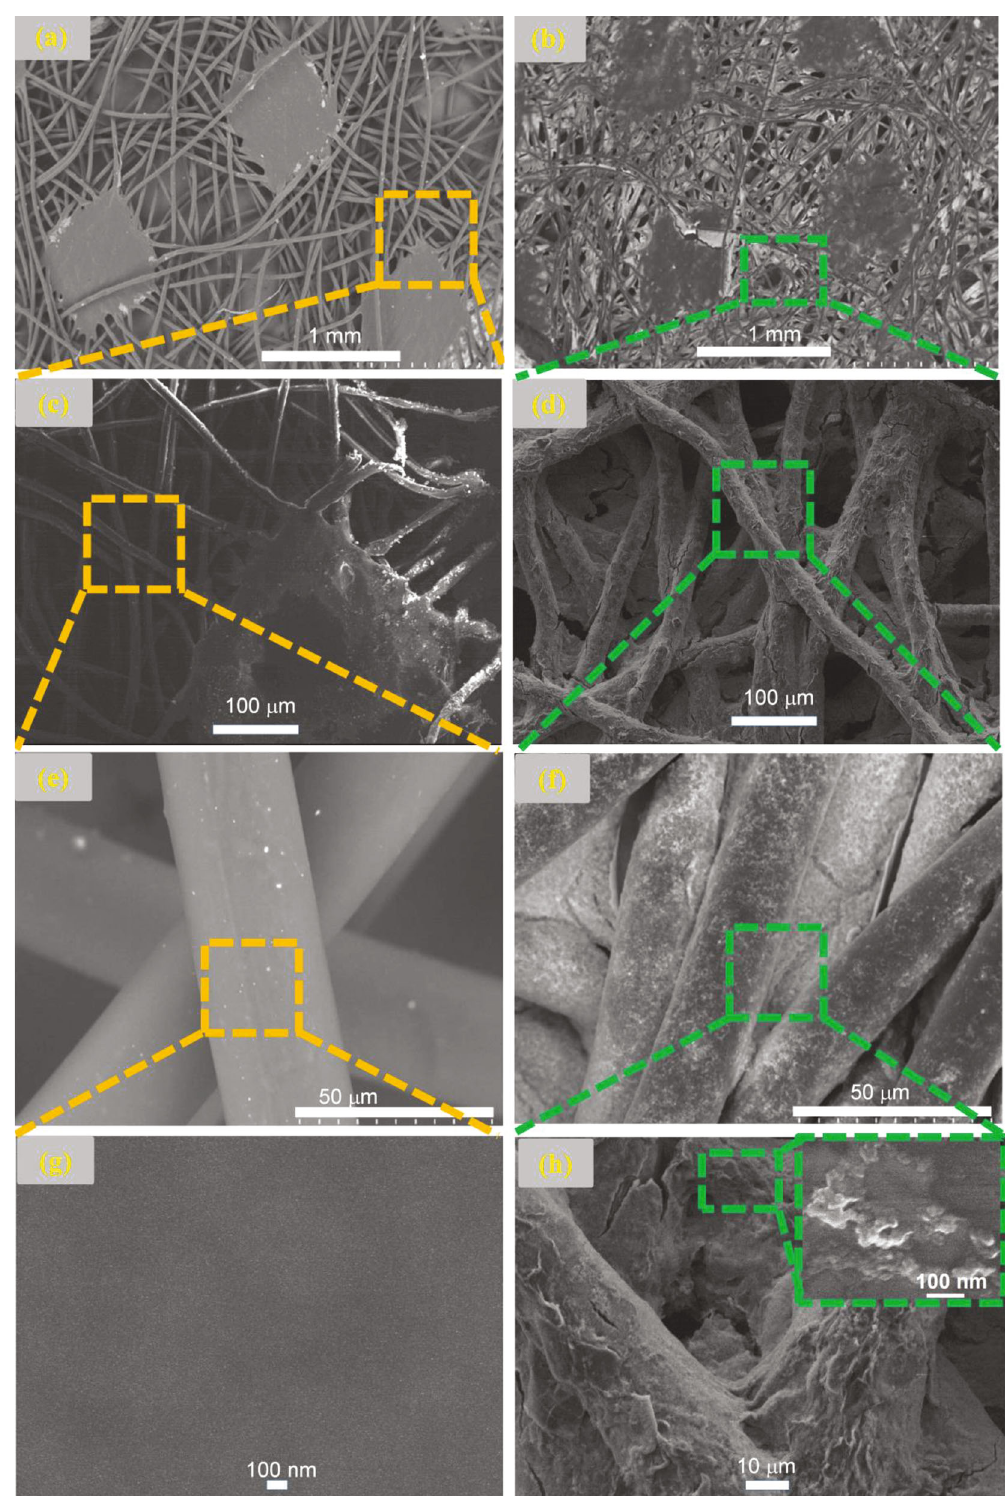
Figure 2: SEM and FESEM images of (a, c, e, g) NWPF and (b, d, f, h)